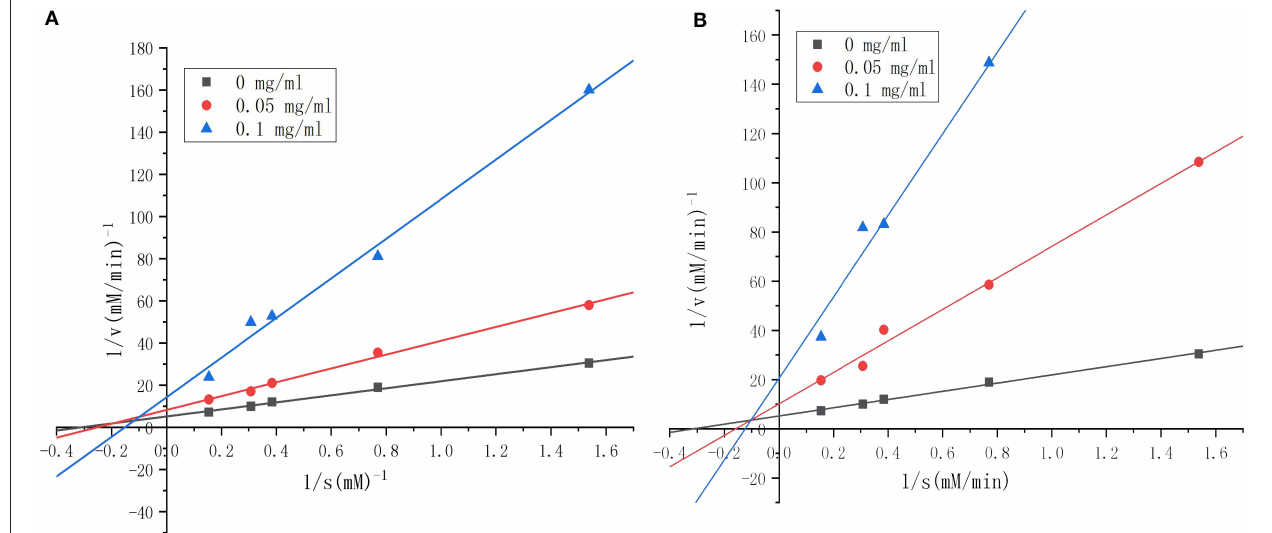
FIGURE 8 | Lineweaver–Burk plots of angiotensin I-converting enzyme (ACE) inhibition by different concentrations of synthesized RWLE peptides across varying substrate concentrations (0–0.1 mg/ml). (A) Lineweaver–Burk plots of peptide H5 and (B) Lineweaver–Burk plots of peptide H6. V = initial rate of reaction [ 1 A 228 (nm)/min].